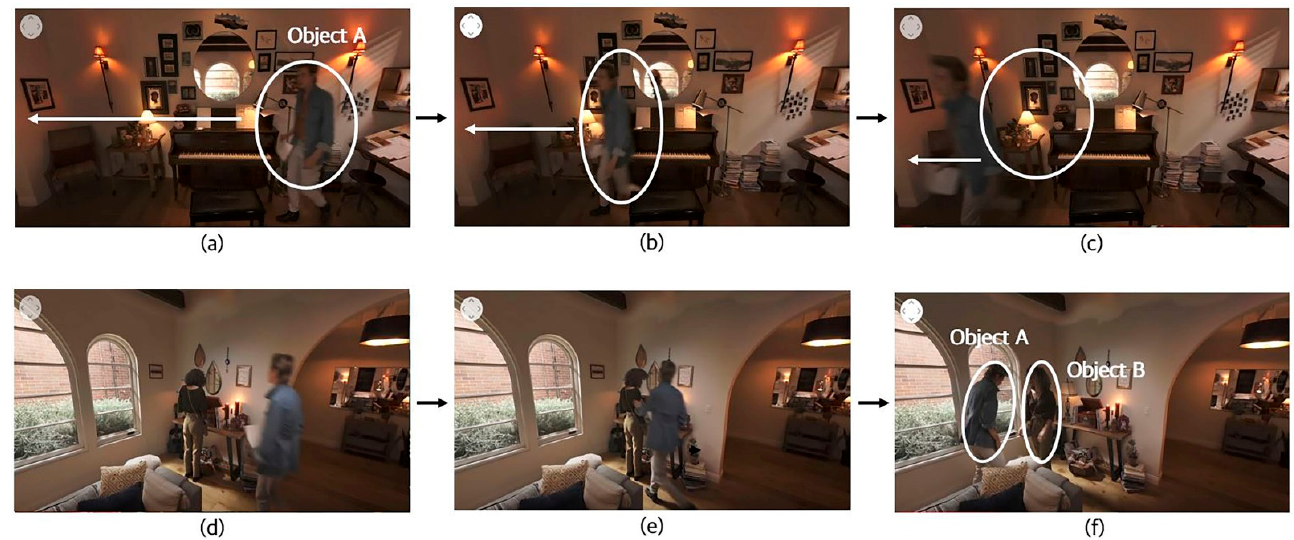
Figure 2. Directed Case 2 using “Object Movement” (video No. 28). ( a – c ) Object A moves to the left in the direction of the arrow, ( d , e ) The user’s attention moves to the left along with object A, ( f ) The scene where objects A and B have a conversation with each other.